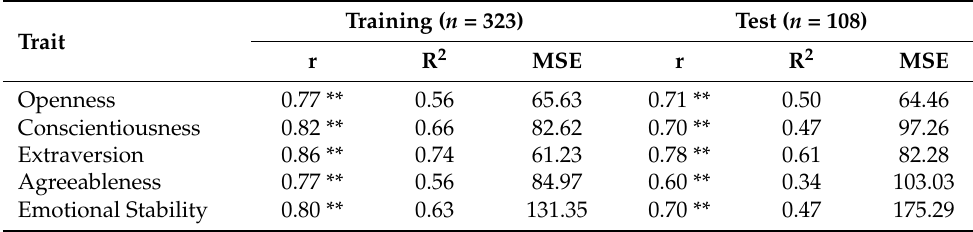
Table 3. The model performance for the image-based assessment. Trait